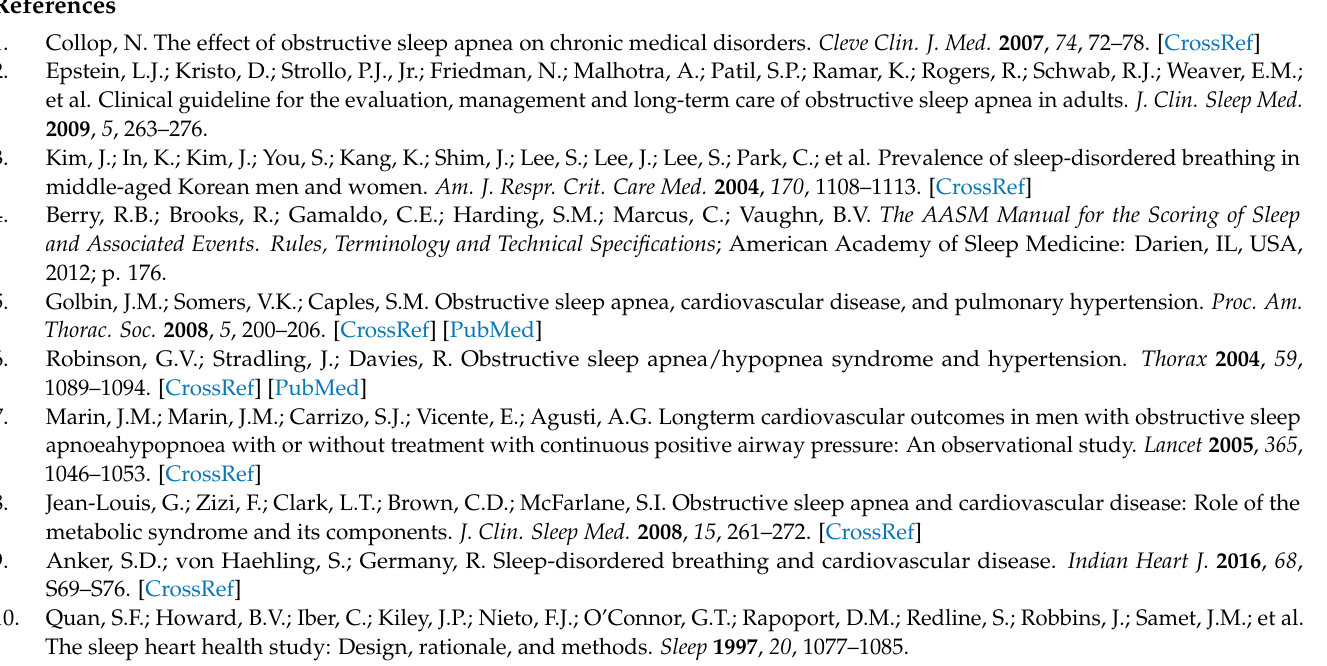
Figure S4: Protocol of prospective cohort study, Figure S5: Participating Institutions of SHHS, Table S1: Subject characteristics of the SHHS dataset, Table S2: Description of 18 signal processing- based ECG features, Table S3: Description of 30 AI-based ECG features, Table S4: Description of 10 clinical CVD risk factors, Table S5: The results of feature selection for each classifier, Table S6: Comparison with other